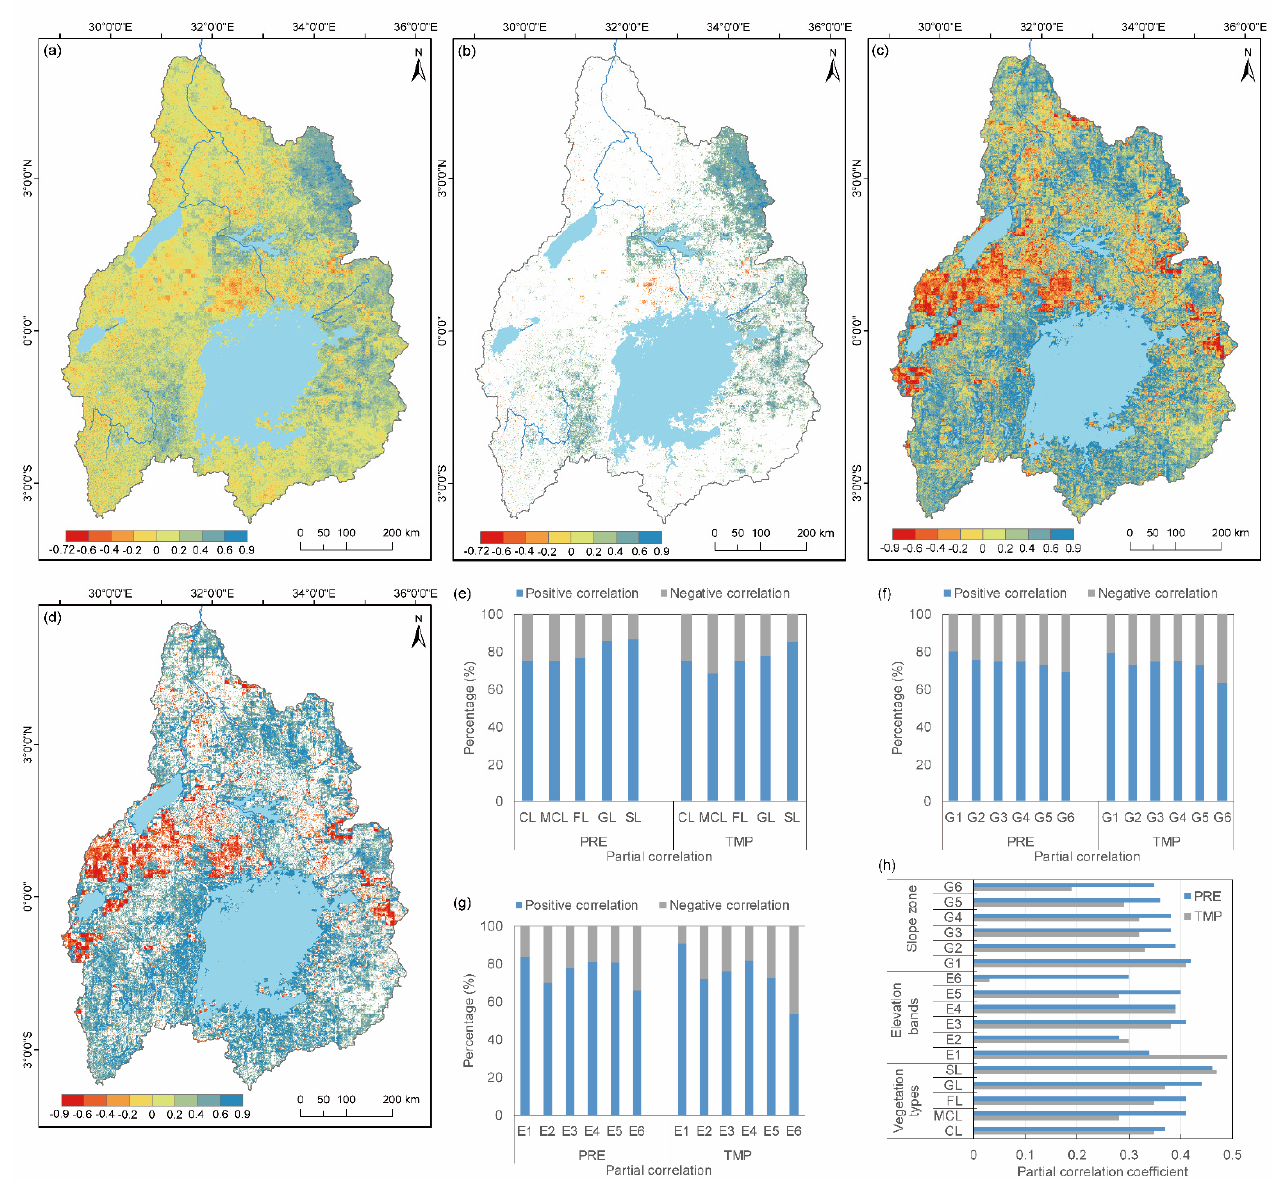
Figure 8. Partial correlation coefficients between vegetation and climate factors. ( a ) Spatial distribution of the partial correlation coefficients between vegetation and PRE. ( b ) Spatial distribution of the partial correlation coefficients between vegetation and PRE that passed the 0.05 significance test. ( c ) Spatial distribution of the partial correlation coefficients between vegetation and TMP. ( d ) Spatial distribution of the partial correlation coefficients between vegetation and TMP that passed the 0.05 significance test. ( e ) The proportion of positive and negative correlations in the area of each vegetation type. ( f ) The proportion of positive and negative correlations in the area of each gradient zone. ( g ) The proportion of positive and negative correlations in the area of each elevation zone. ( h ) The average partial correlation coefficient in different vegetation types, elevation zones and gradient zones. Note: The partial correlation value in Figure 8h is the average value of the area that passed the 0.05 significance test.